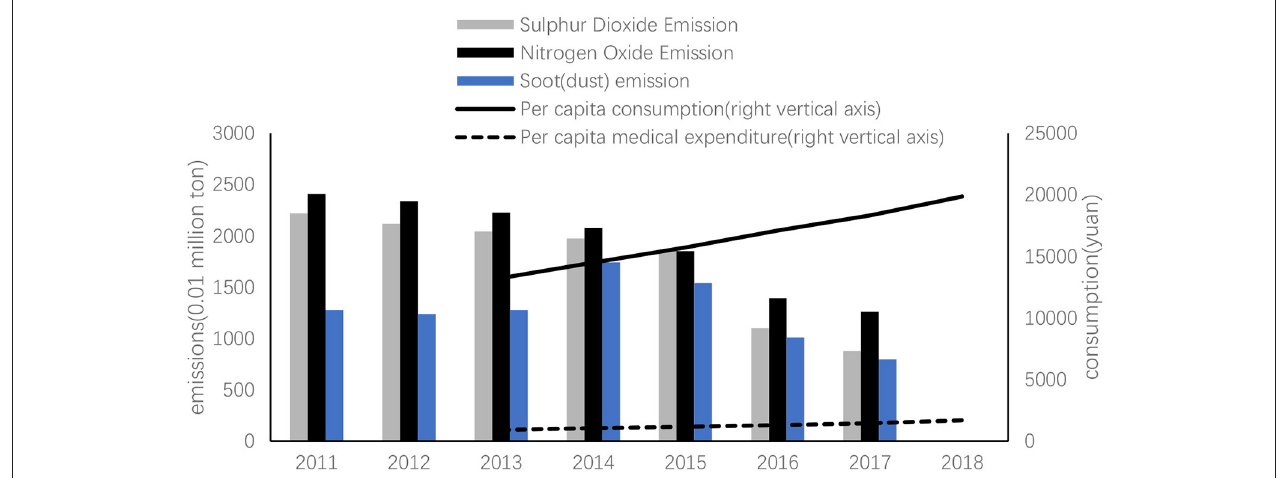
FIGURE 1 | The trend of consumption, medical expenditure, and primary pollutants